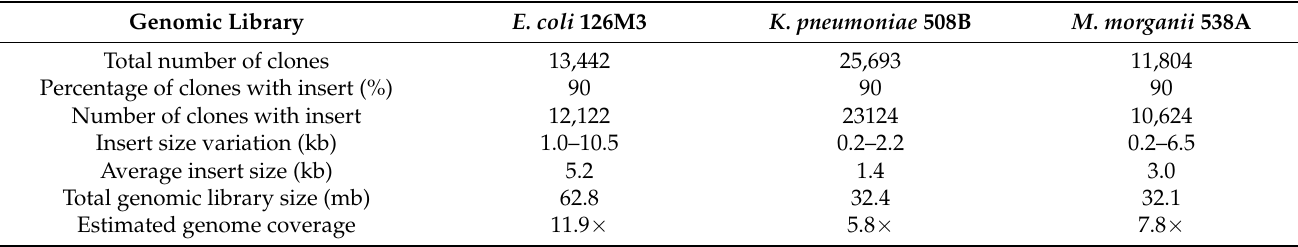
Table 1. Features of the generated genomic